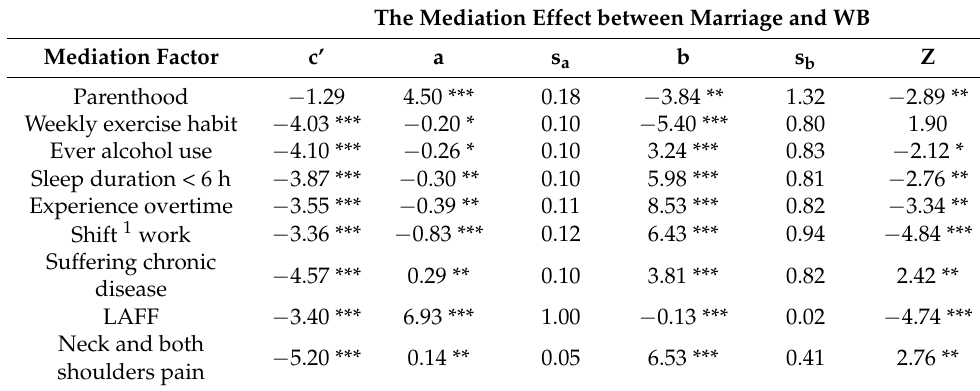
Table 6. Mediation Models on the Relationship between Marriage and